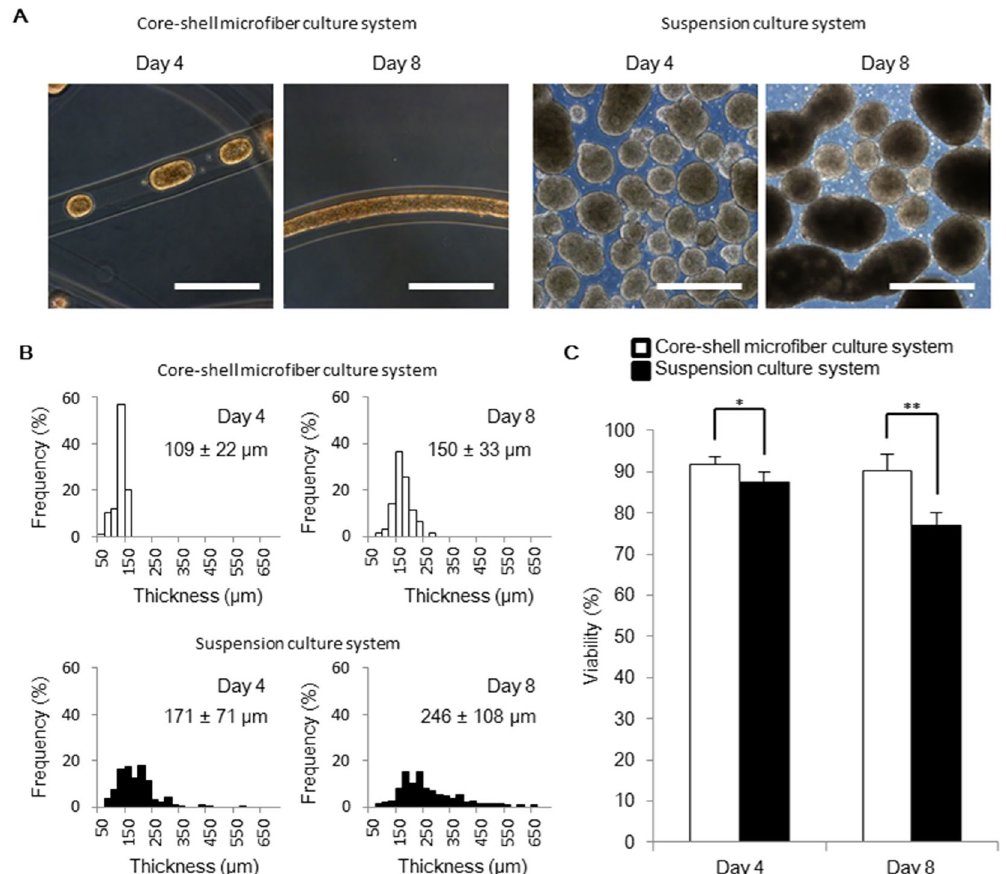
Figure 2. The thickness and the viability of human iPS cell aggregations in the core-shell microfiber culture system. ( A ) Microscopic images showing the morphologies of human iPS cell aggregations in the core-shell microfiber culture and the suspension culture systems on day 4 and 8. Scale bar: 500 μ m. ( B ) Thickness distributions of cell aggregations in the core-shell microfiber culture and the suspension culture systems on days 4 and 8. The thickness was calculated by measuring the minor axis of cell aggregation regarded as an ellipse. ( C ) The cell viabilities in the core-shell microfiber culture and the suspension culture systems after the retrieval of cell aggregations from the microfibers and dissociation of cell aggregations into single cells on days 4 and 8 (N ≥ 3). * P <